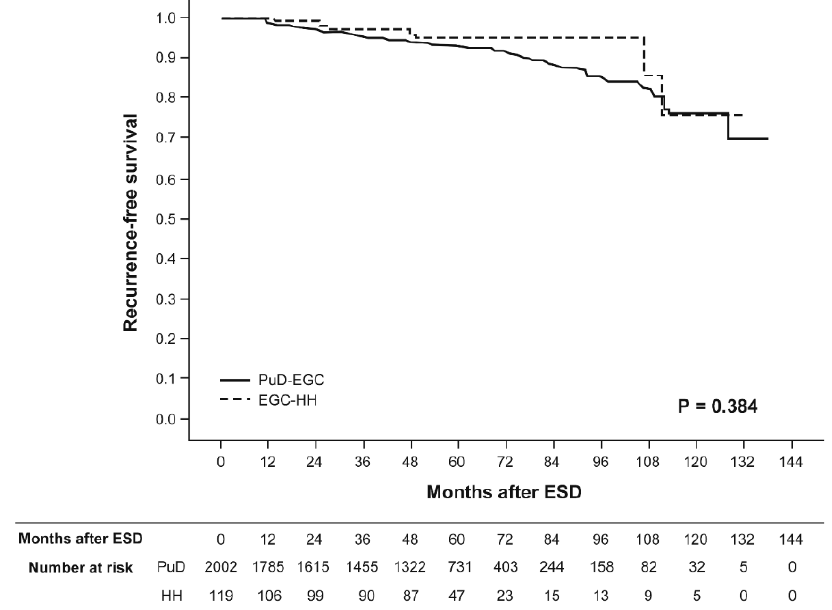
Figure 4. Kaplan–Meier recurrence-free survival curves for patients undergoing curative endoscopic submucosal dissection. Solid line, pure differentiated-type early gastric cancer (PuD-EGC); dotted line, differentiated-type-predominant early gastric cancer with histological heterogeneity (EGC-HH).